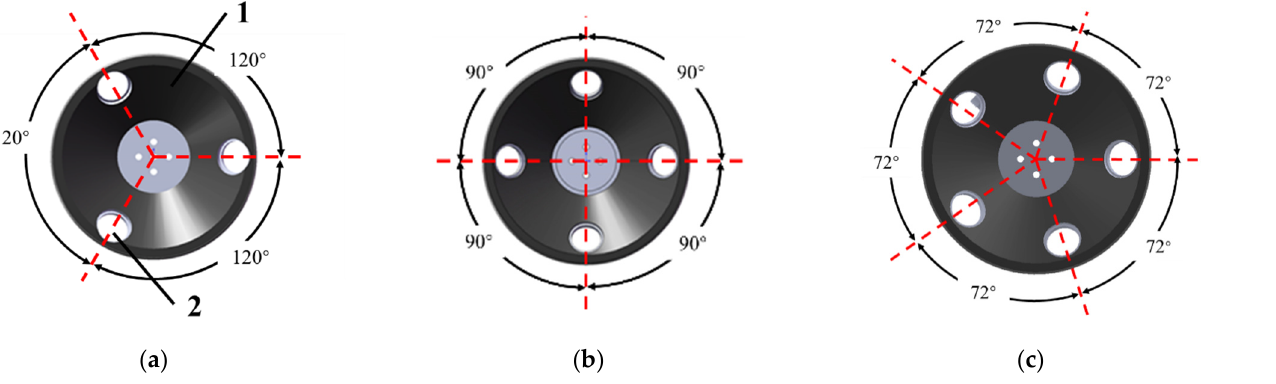
Figure 18. Three suction cup layout designs: ( a ) 120° suction cup layout; ( b ) 90° suction cup layout; ( c ) 72° suction cup layout, where 1: mechanical hand; 2: mounting holes.